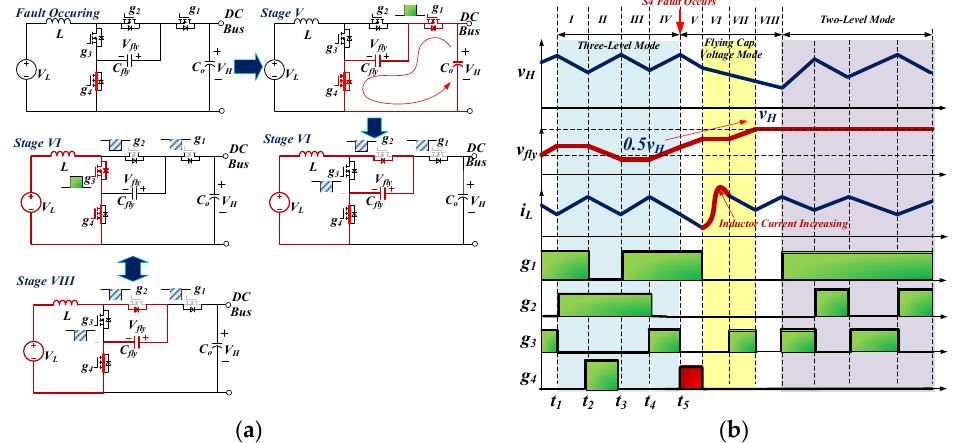
Figure 13. Short-circuit fault analysis (V L > 0.5 V H ). ( a ) The stages when S 4 is short-circuited; ( b ) stage analysis.